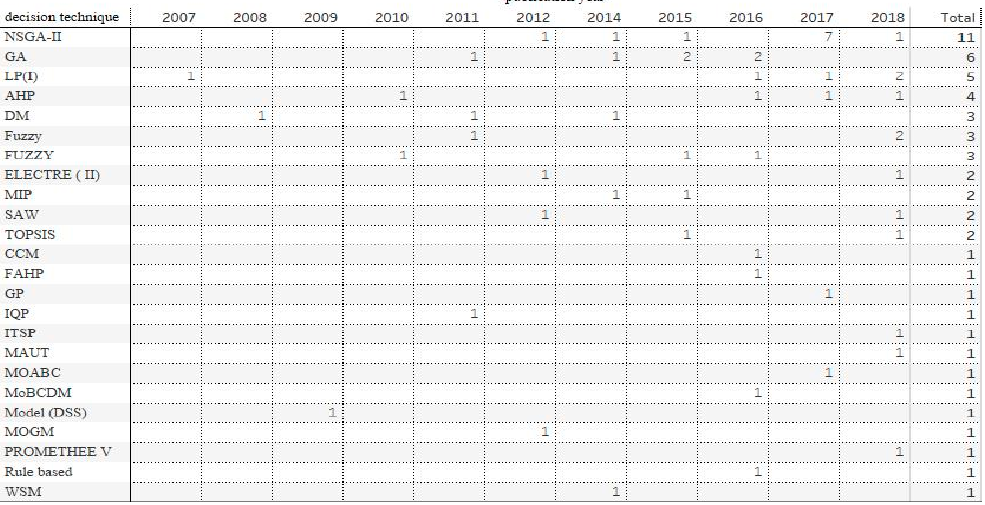
Figure 6. Distribution of decision technique type based on publication year. FUZZY = Fuzzy stochastic programming; fuzzy = simply fuzzy method.